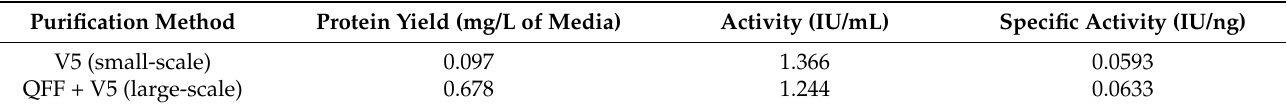
Table 2. rADAMTS13 protein purified from flasks via V5 or QFF + V5. Purification Method